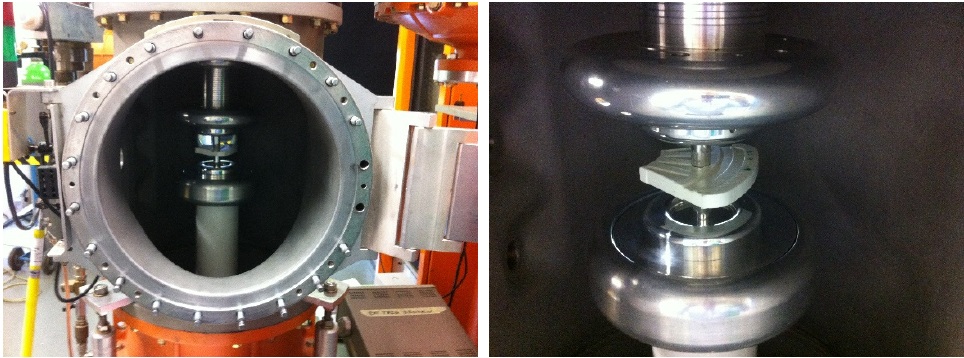
Figure 2. The barrier insulator disks during the electrical breakdown strength testing.